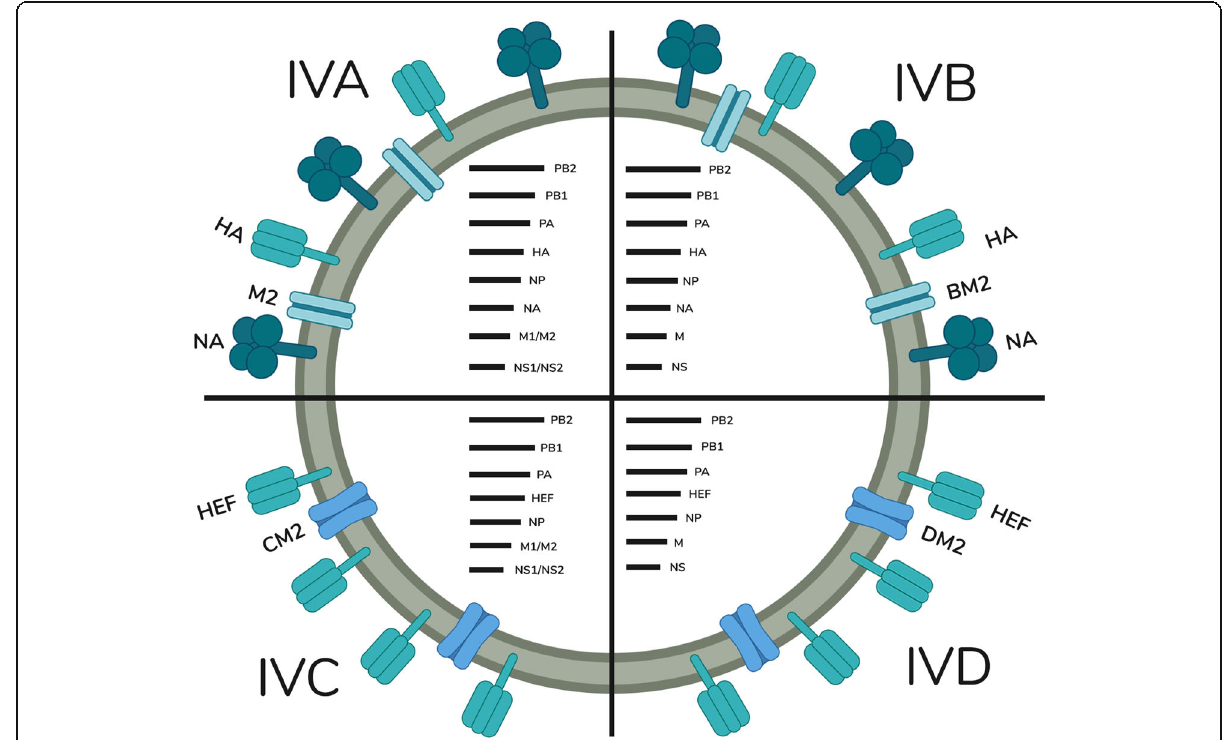
Fig. 1 Structure of influenza viruses A, B, C, and D with their genomic arrangements